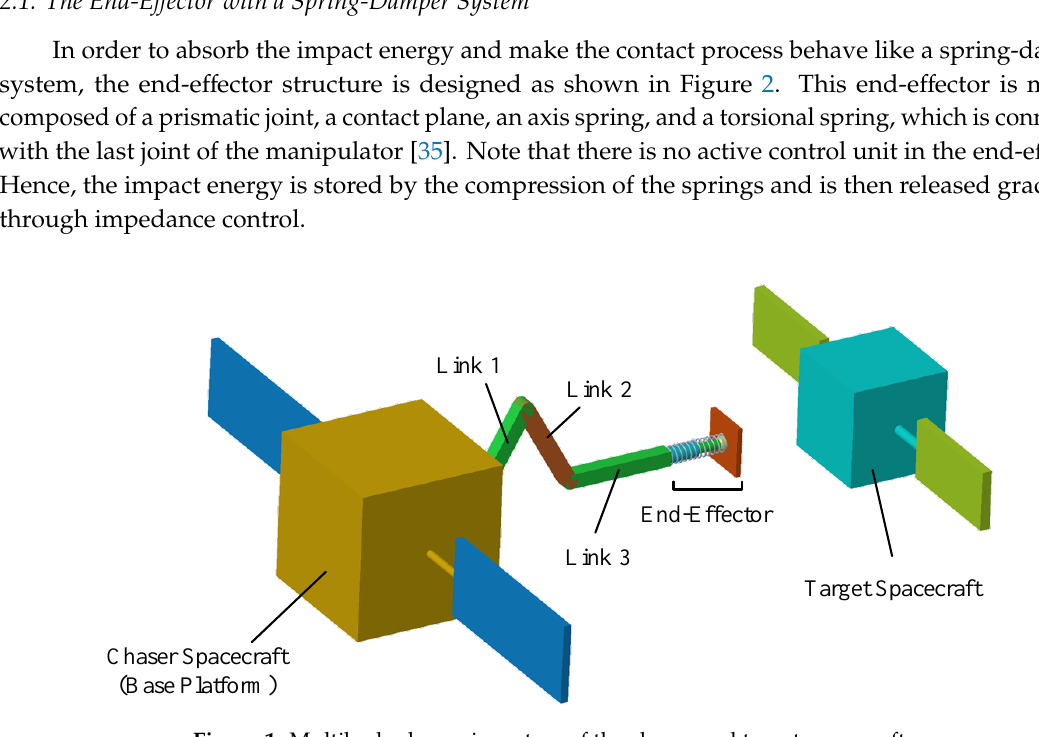
represent the s and s represent the stiffness represent the stiffness ts td Δx and Δθ represent the offsets of Δx and s s s Δθ represent the offset velocity of axis Δx and  Δx and  s s s